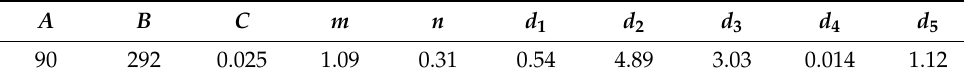
Table 3. Johnson–Cook material parameters of the rotating